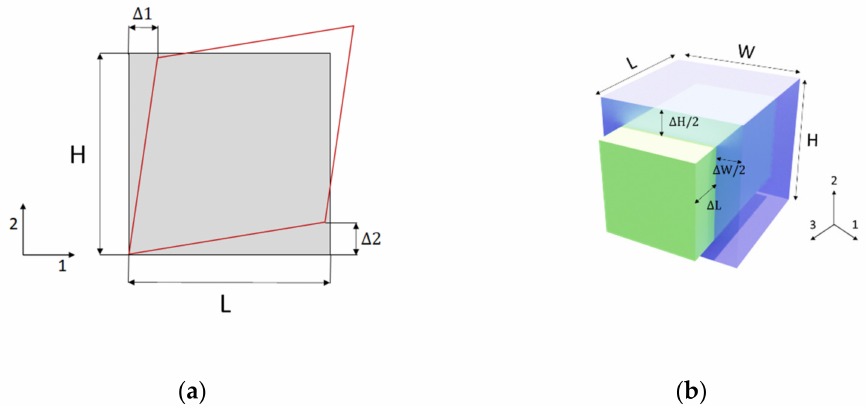
Figure 7. ( a ) Deformed part schematization of displacement to evaluate G 12 ; ( b ) 3D schematization of the load case to evaluate E 11 and Poisson’s ratios ν 12 and ν 13 .